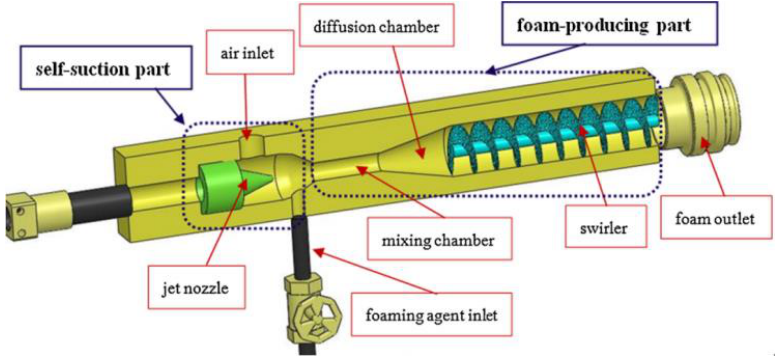
Figure 2. Schematic of the foam generator proposed by Wang et al. [6].